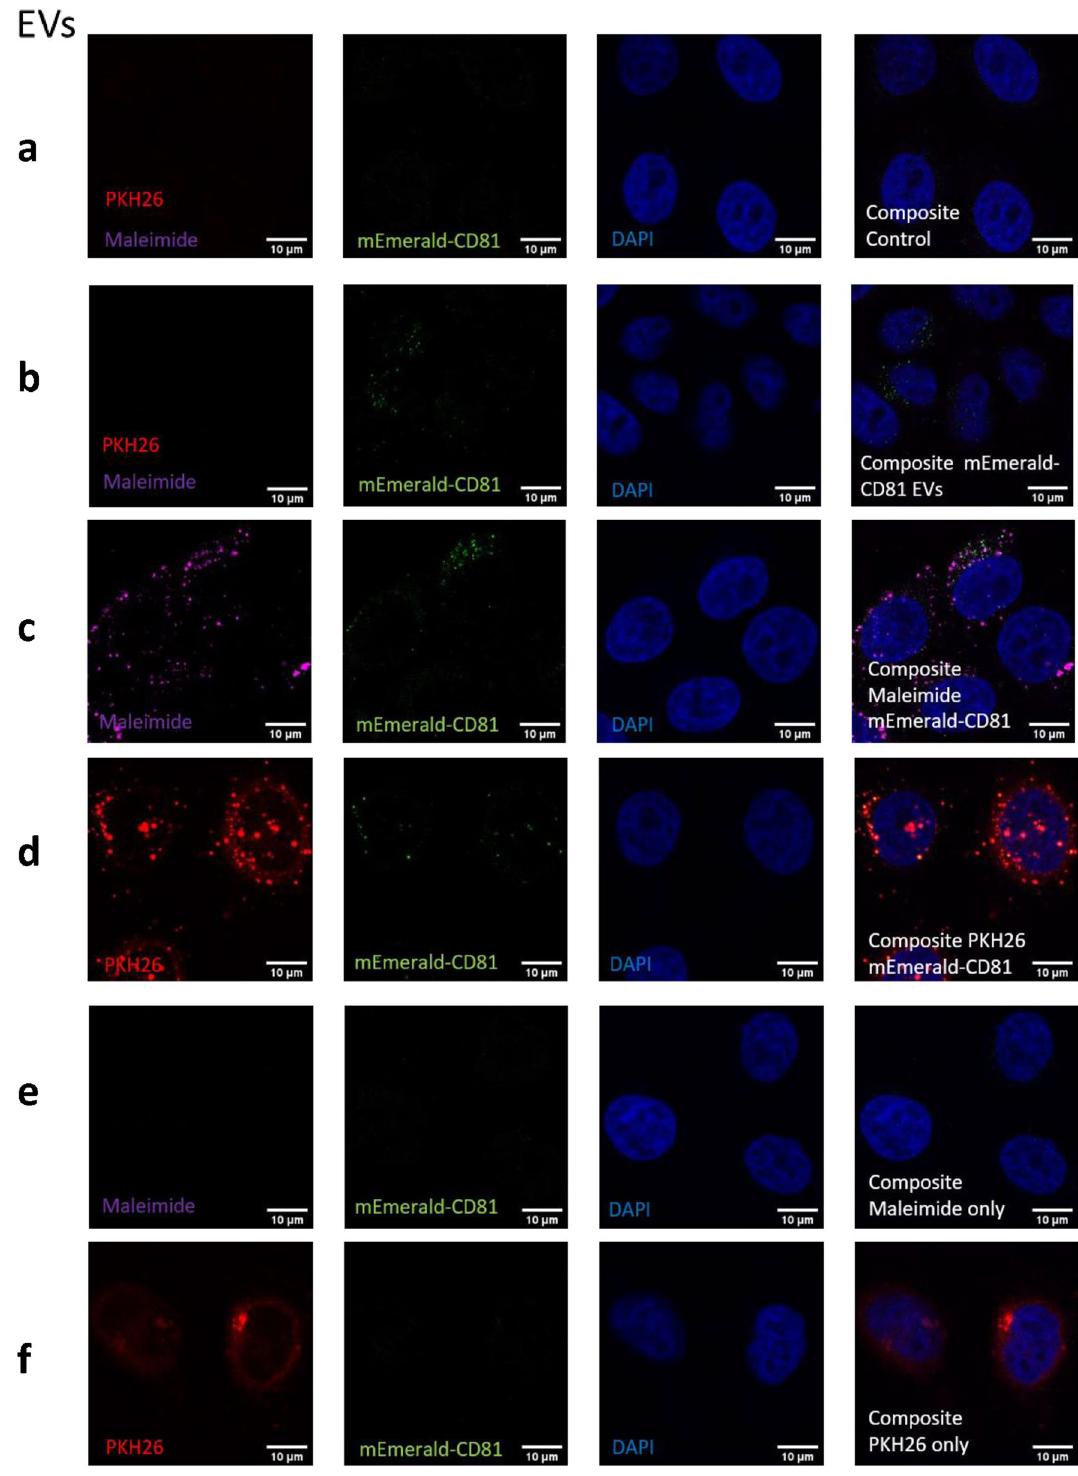
Figure 4. Uptake of dual stained mEmerald-CD81 EVs. Representative confocal images of fixed control (untreated) HeLa cells ( a ) or HeLa cells treated with control (unstained) mEmerald-CD81 EVs ( b ), maleimide C5 AF633 ( c ) or PKH26 ( d ) dual stained EVs, maleimide only ( e ) or PKH26 only ( f ) for 3 h. Scale bars are 10